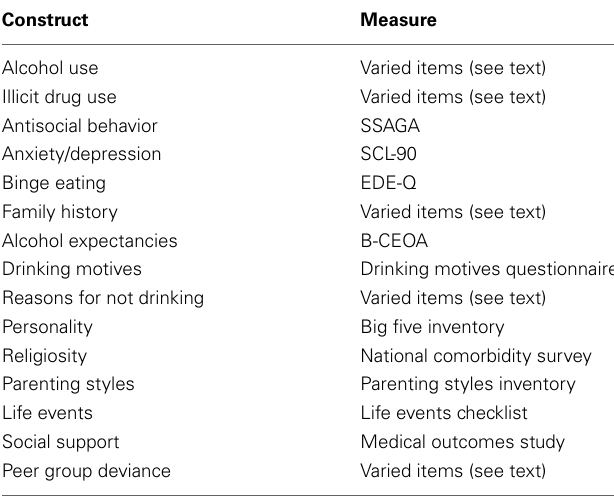
Table 1 | Overview of measures assessed in Spit for